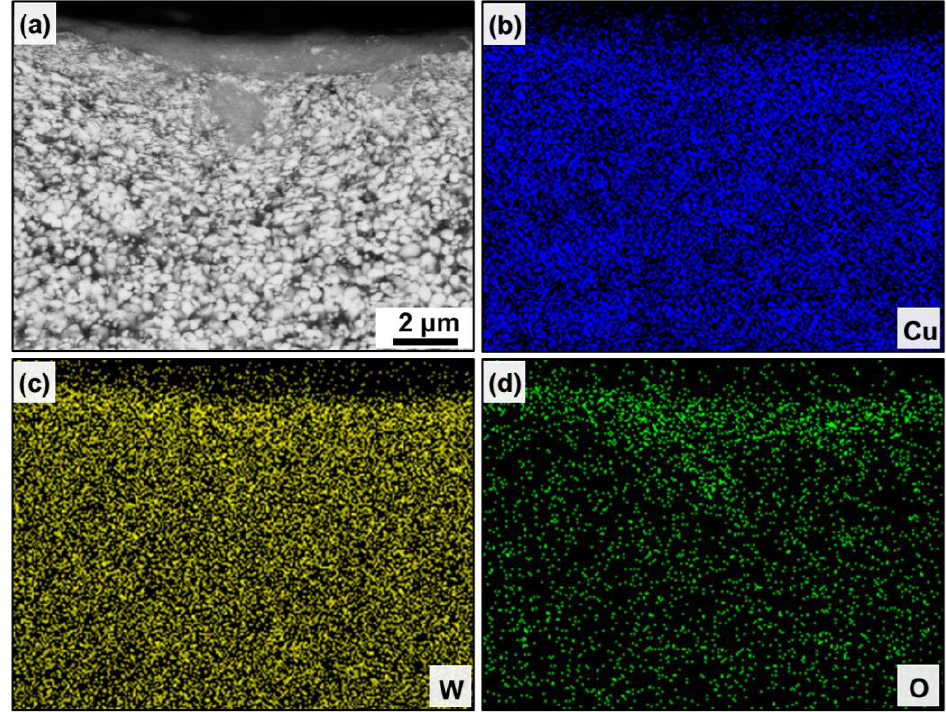
Figure 6. ( a ) Cross-sectional microstructure under the wear scar of the CCG W–Cu composite and ( b – d ) the corresponding elemental distributions.